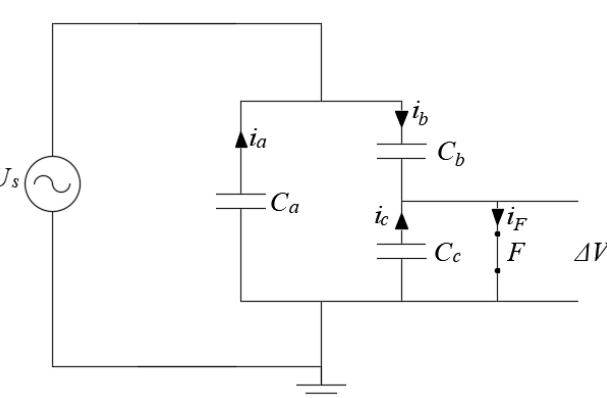
Figure 4. Three-capacitance model representation during a PD event. When a PD occurs, Cc is short-circuited by the spark gap F and a transient current will flow. In addition, voltages will be modified by the transient phenomenon.